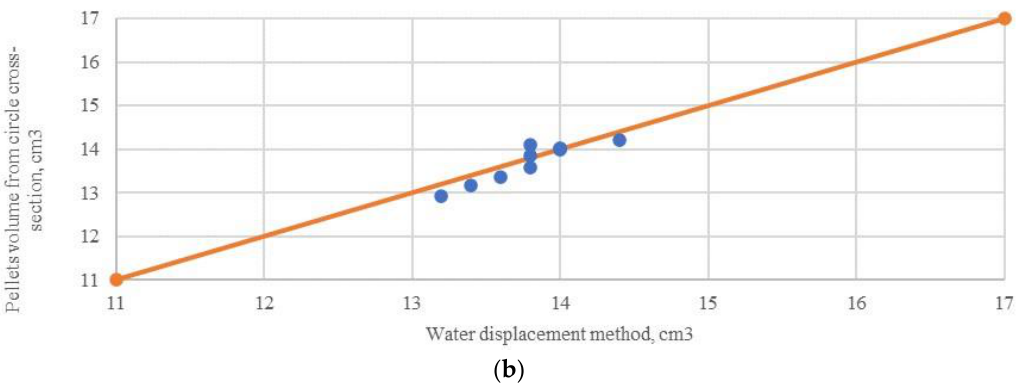
Figure 10. Measuring of volume of formed pellet model based on imaging method of processing of digital images: ( a ) ratio between results produced by approximation of ellipsoid volume method and water displacement method; ( b ) ratio between results produced by approximation of pellet volume by dividing pellet’s volume into layers of circles and water displacement method. Table 1. Calculation of volume of pellet model (pellet was divided into circular layers).